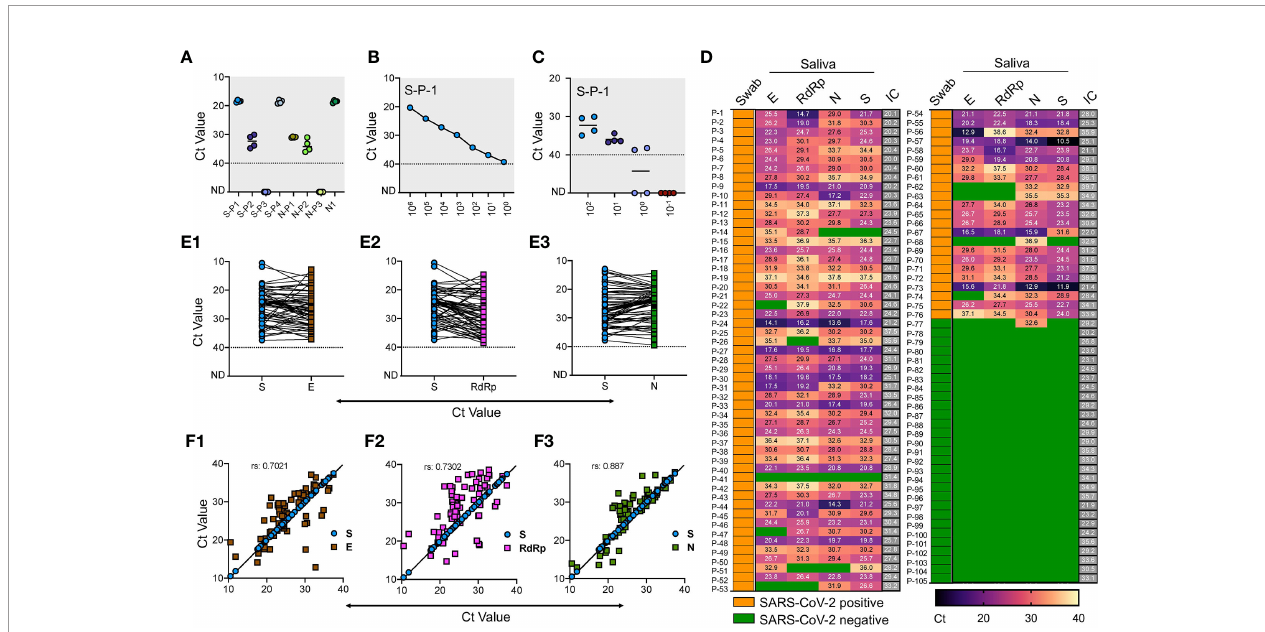
FIGURE 1 | Validation of saliva-based detection of SARS-CoV-2 in clinical samples (A) Standardization of SARS-CoV-2 speci fi c primer pairs for S and N gene. Primers are labeled as S-P1 to S-P-4 for S gene and N-P1 to N-P-3 for N gene, N1 represents the CDC approved primer for N gene. Dotted line indicates lower level of detection; ND indicates not detected (B) Determination of limit of detection using RNA of S spiked into RNase free water with serial dilutions. (C) RNA extracted from four normal saliva samples was used at various copy numbers to fi nd any interference for detection of spiked-in SARS-CoV-2 S gene RNA. (D) Heat map of 105 saliva samples showing RT-qPCR results represented as Ct values for E, N, RdRp and S genes respectively. The test results of these samples were validated by the hospital using swab samples, and represented as Swab. IC is the internal control. Green boxes represent the samples with Ct values not detected and were labeled as SARS-CoV-2 negative, and yellow boxes indicate swab samples positive for SARS-CoV-2. (E1-E3) Shows the Ct value comparison between S gene with E, RdRp, and N gene respectively. (F1-F3) Shows the spearman correlation of Ct values between S gene with E, RdRp, and N gene